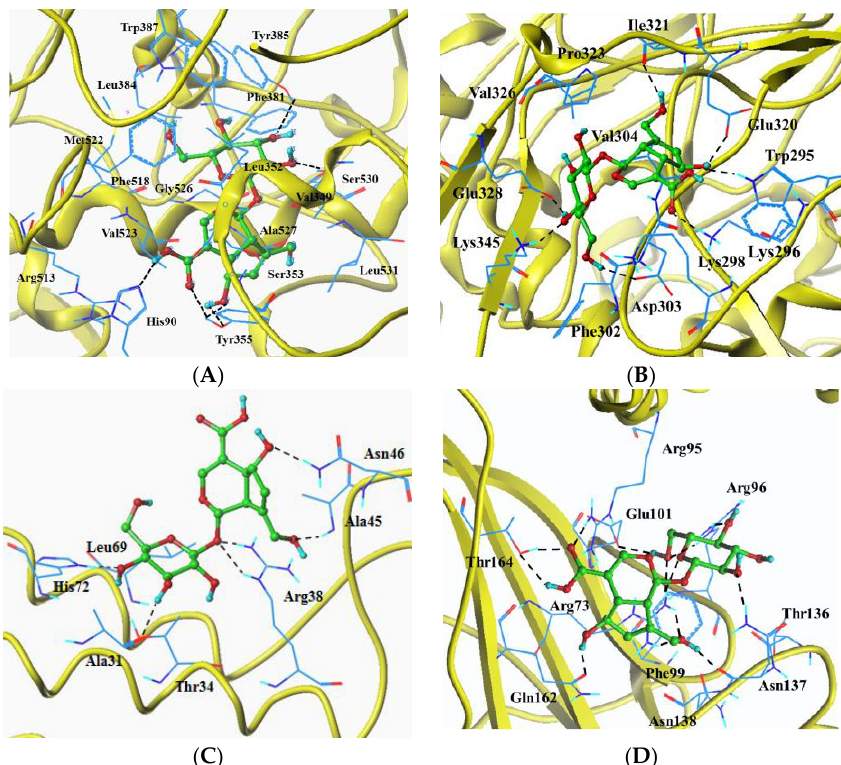
Figure 7. The best docked pose of SCA with target proteins. Docked orientation of SCA (colored in green) with corresponding secondary protein structure (colored in yellow) and amino acid residues (colored in blue) of COX-2 (1CX2) ( A ); iNOS (4NOS) ( B ); PEG 2 (4AL0) ( C ) and IκB (1NFI) ( D ).